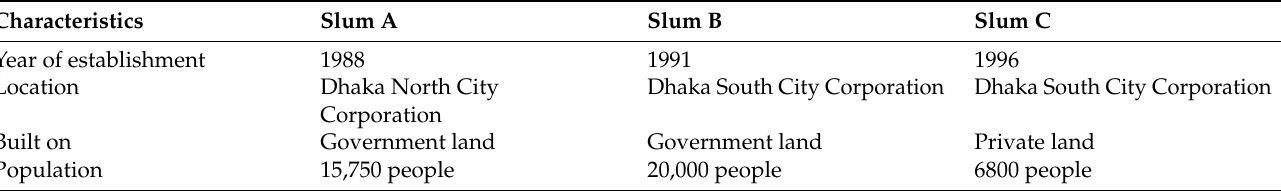
Table 1. Characteristics of the three study